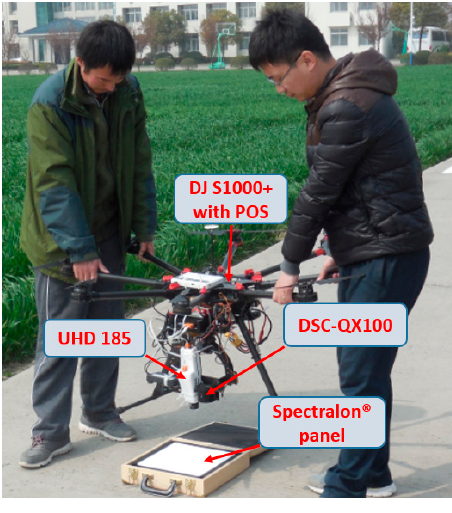
Figure 1. The experimental site.